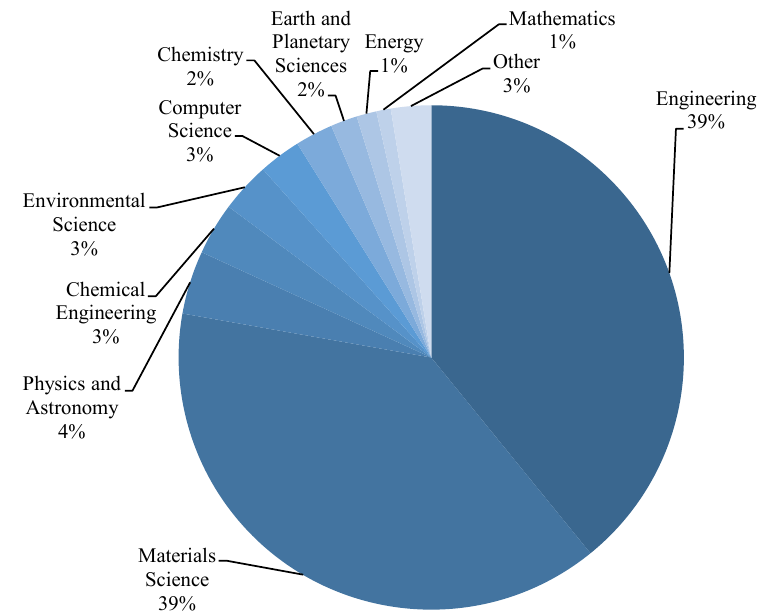
Figure 2. Relevant subject areas containing publications on FRGP studies.